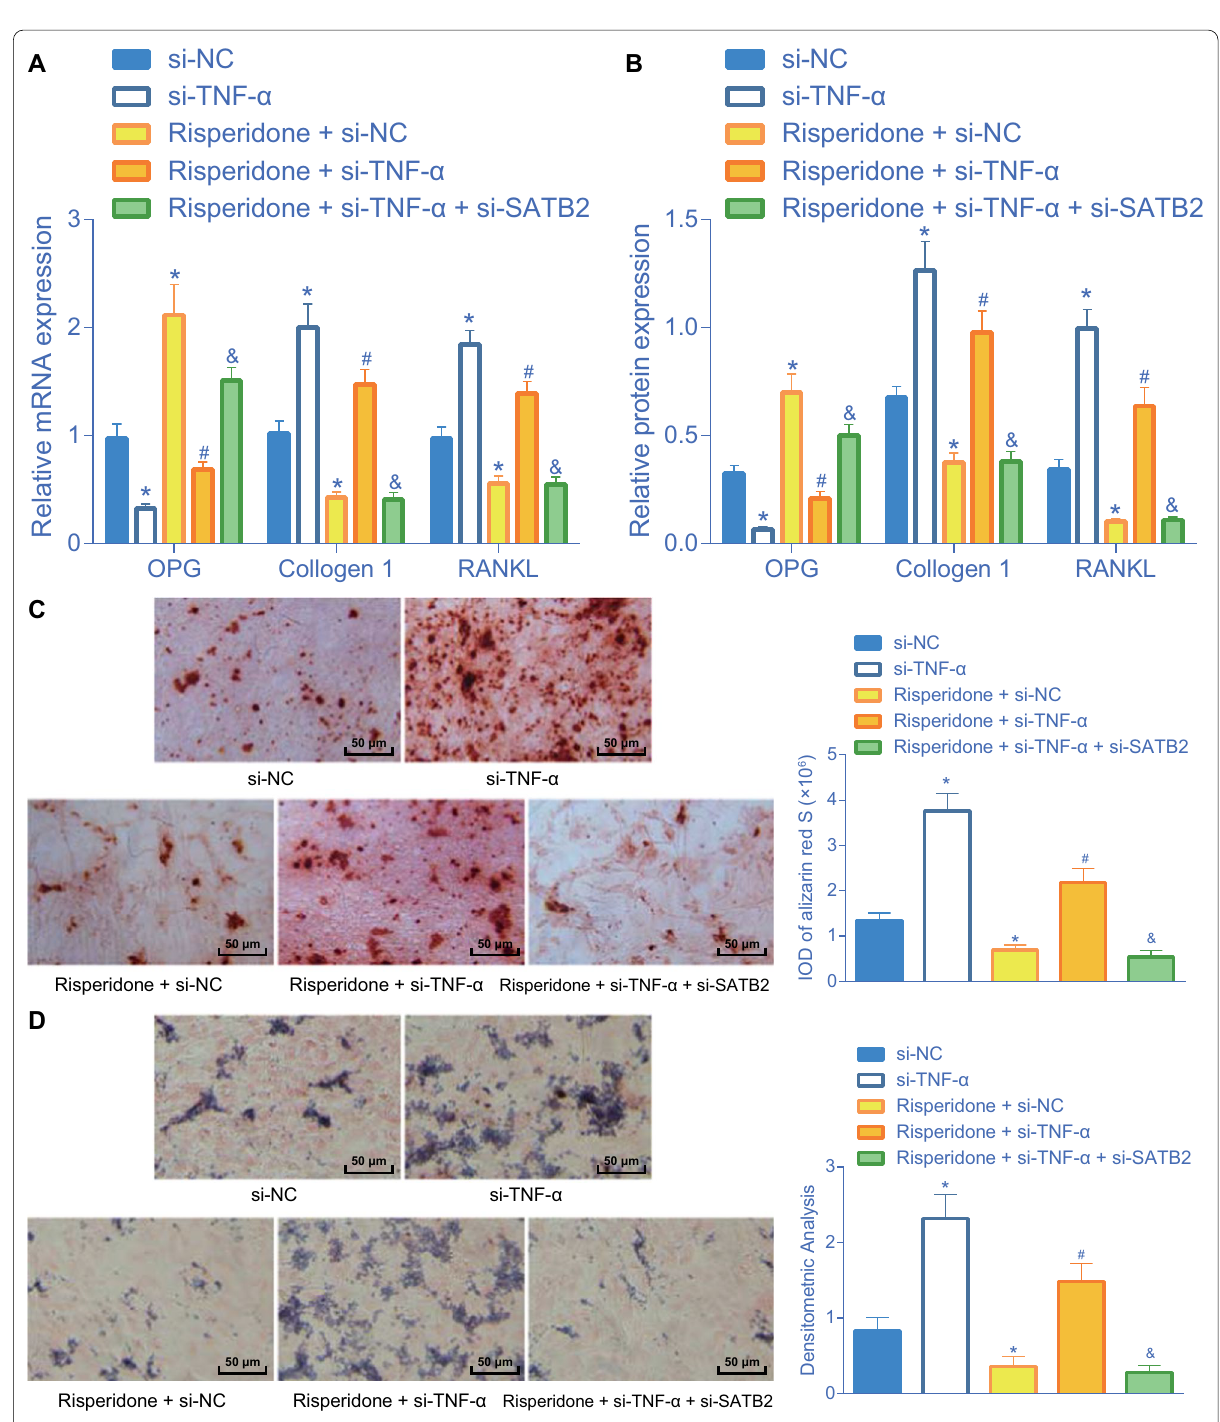
Fig. 5 Risperidone inhibits osteoblast differentiation through the TNF-α/SATB2 axis. A the mRNA expression of OPG, collagen I and RANKL in MC3T3-E1 cells determined by RT-qPCR. B Western blot analysis of OPG, collagen I and RANKL expression in MC3T3-E1 cells. The protein band was assessed. C repesentative images and statistical analysis of positive Alizarin red S staining in MC3T3-E1 cells. D repesentative images and statistical analysis of positive ALP staining in MC3T3-E1 cells. * p < 0.05, compared with MC3T3-E1 cells treated with si-NC. # p < 0.05, compared with MC3T3-E1 cells treated with Risperidone si-NC. & p < 0.05, compared with MC3T3-E1 cells treated with Risperidone si-TNF-α. The cell experiments are + + repeated 3